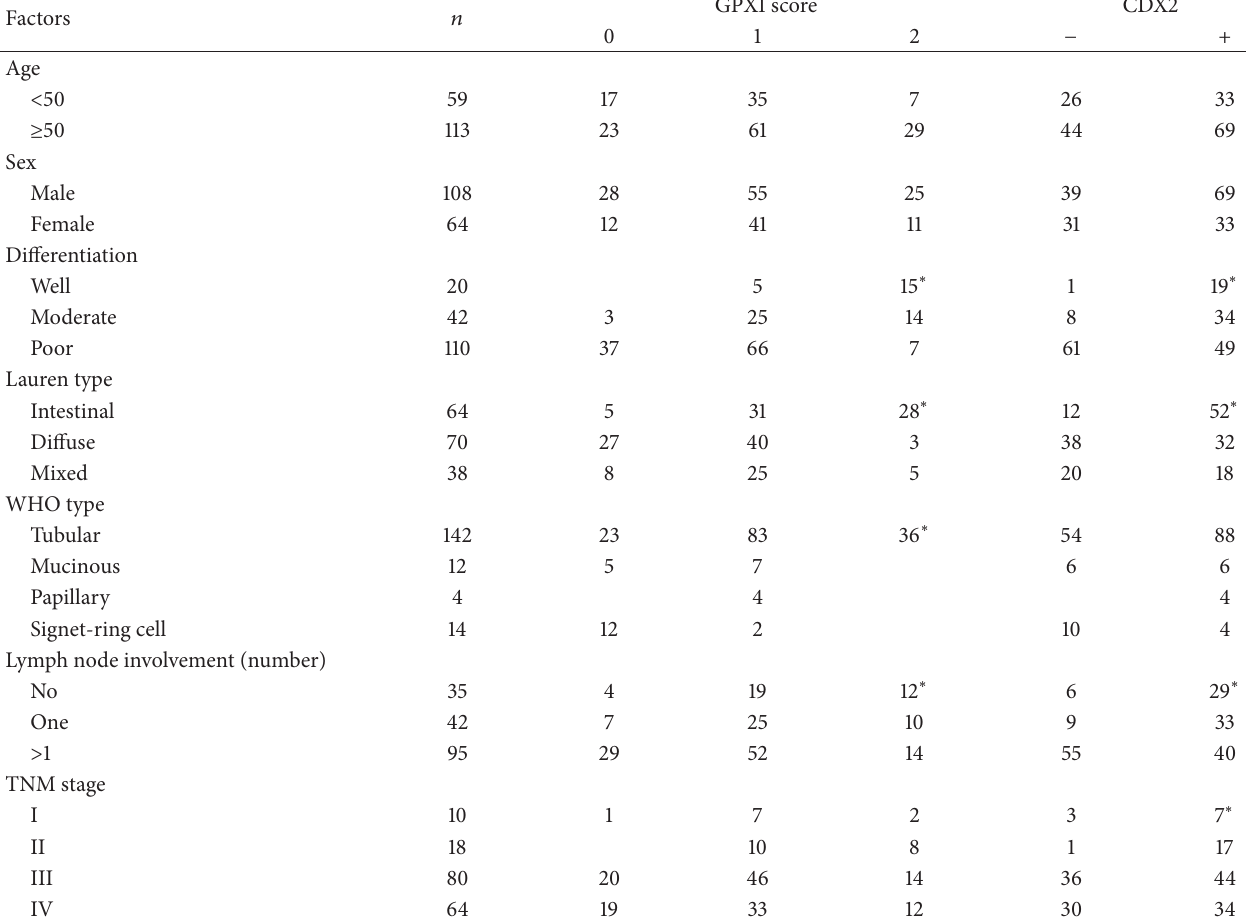
Table 1: Relationship of GPX1 and CDX2 expression with clinicopathological factors of GAC.